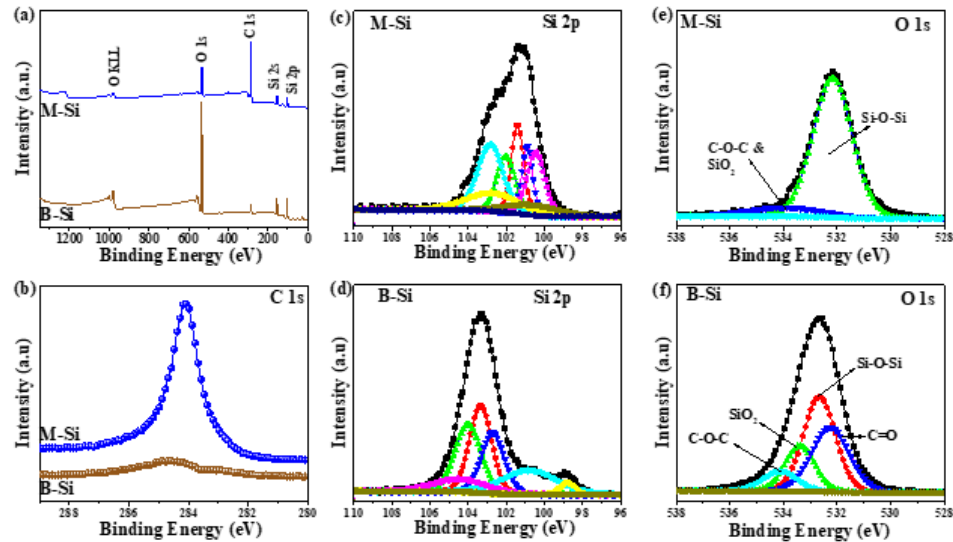
Figure 3. X-ray photoelectron spectra (XPS) of M-Si and B-Si: ( a ) survey scan, ( b ) C 1s, ( c , d ) Si 2p, and ( e , f ) O1s, respectively.